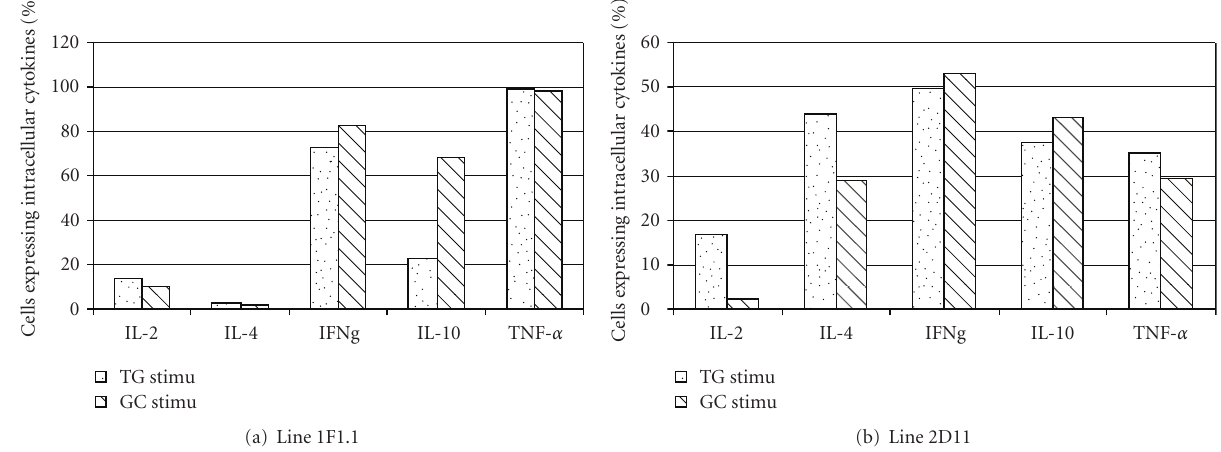
Figure 4: Cytokine response of two iNKT cell lines. Cells were stimulated with thyroglobulin or α -GalCer four hours prior to staining. Intracellular cytokine expressions were then detected by flow cytometry as described in methods. Both lines showed a burst of cytokines after 4 hours of stimulation. (a) Line 1F1.1 showing high levels IFN- γ , but low levels of IL-4. (b) Line 2D11 showing elevated levels of both IFN- γ and IL-4. Data represents percent of total iNKT cells expressing intracellular